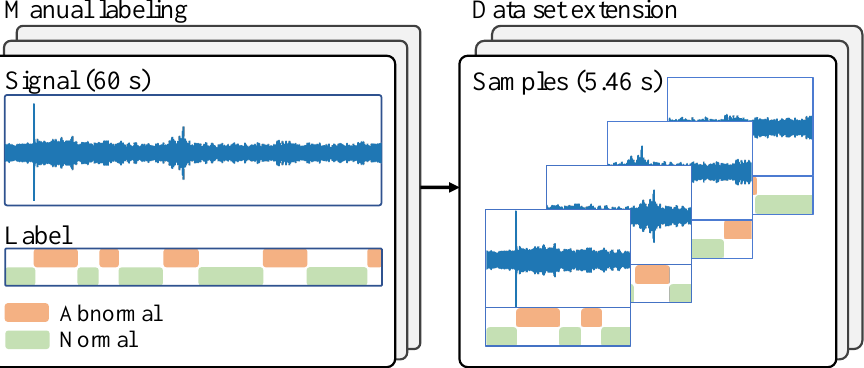
Figure 7. Manual labeling and data set